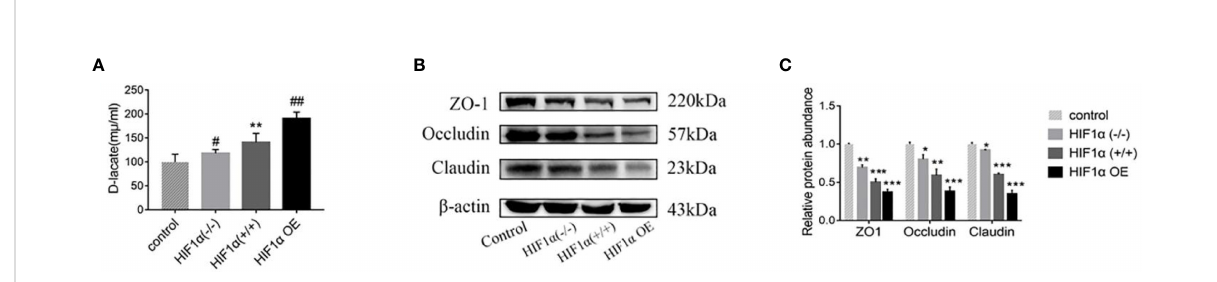
FIGURE 3 Upregulation of the HIF1 a gene aggravates the permeability of the intestinal mucosa. (A) Blood was collected from the eyeball of nude mice after anesthesia, and the concentration of D-lactic acid in plasma was detected by ELISA (n = 5). HIF1 a (+/+) group, ** P <0.01 vs . control group; HIF1 a (-/-) group, HIF1 a OE group, # P <0.05, ## P <0.01 vs . HIF1 a (+/+) group. (B) The expression of ZO1 and occludin in the intestinal mucosa of tumor-bearing mice with different HIF1 a gene expression was detected. (C) Quantitative data of (B) . HIF1 a group, * P <0.05, ** P <0.01, *** P <0.001 vs . control group.